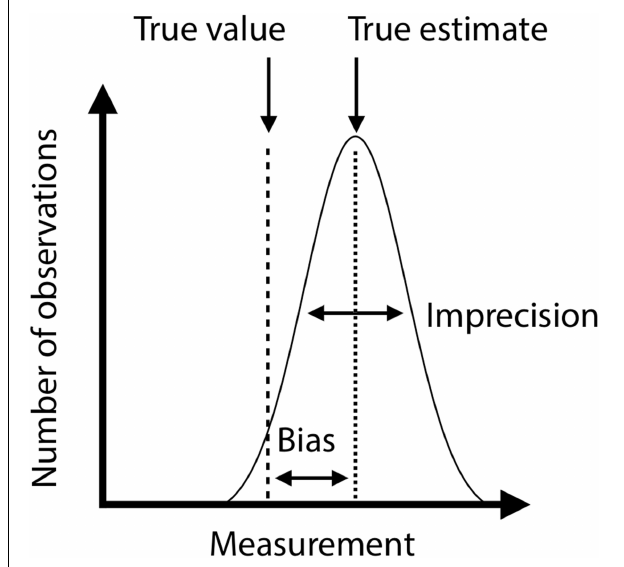
FIGURE 5 | Schematic illustration of bias and imprecision. X-axis represents phenotypic values and Y-axis represents number of observations. The gaussian curve shows the distribution of repeated measurements of the same specimen. Dashed line is the true estimate, and the variance of measurements around the true estimate is the imprecision. The true value may deviate systematically from the true estimate (long-dashed line). The difference between true estimate and true value is the